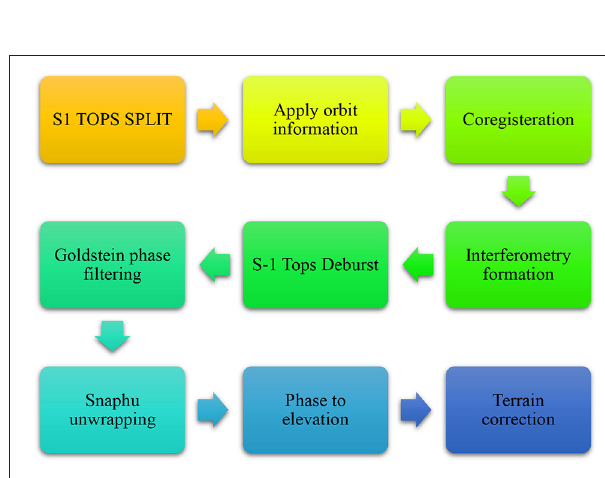
FIGURE 2 | Flowchart of methodology adopted to extract water level using